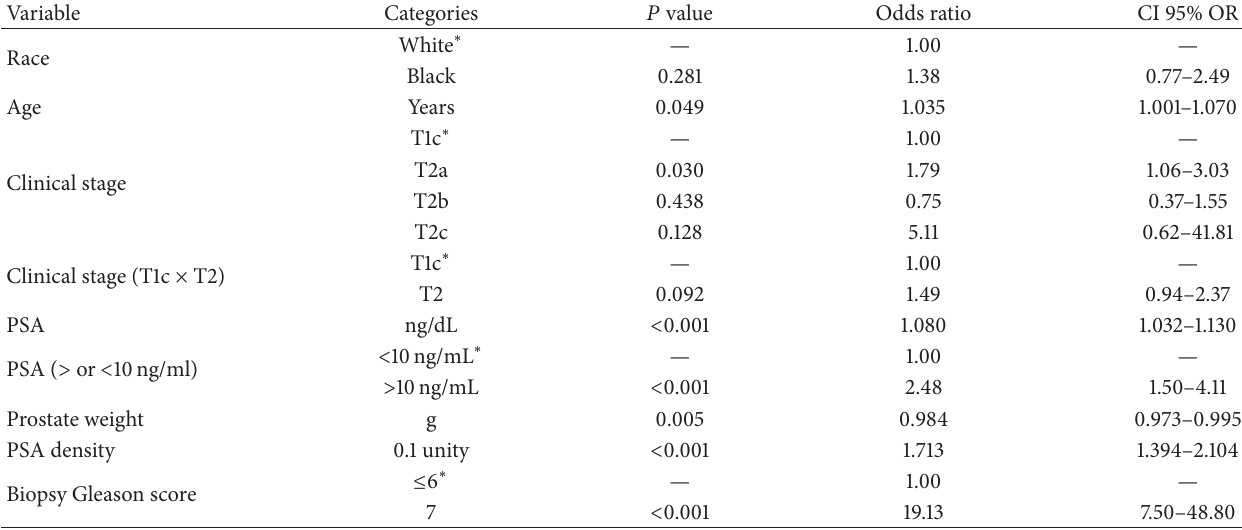
Table 2: Univariate logistic regression analysis to preoperatively predict Gleason discordance.